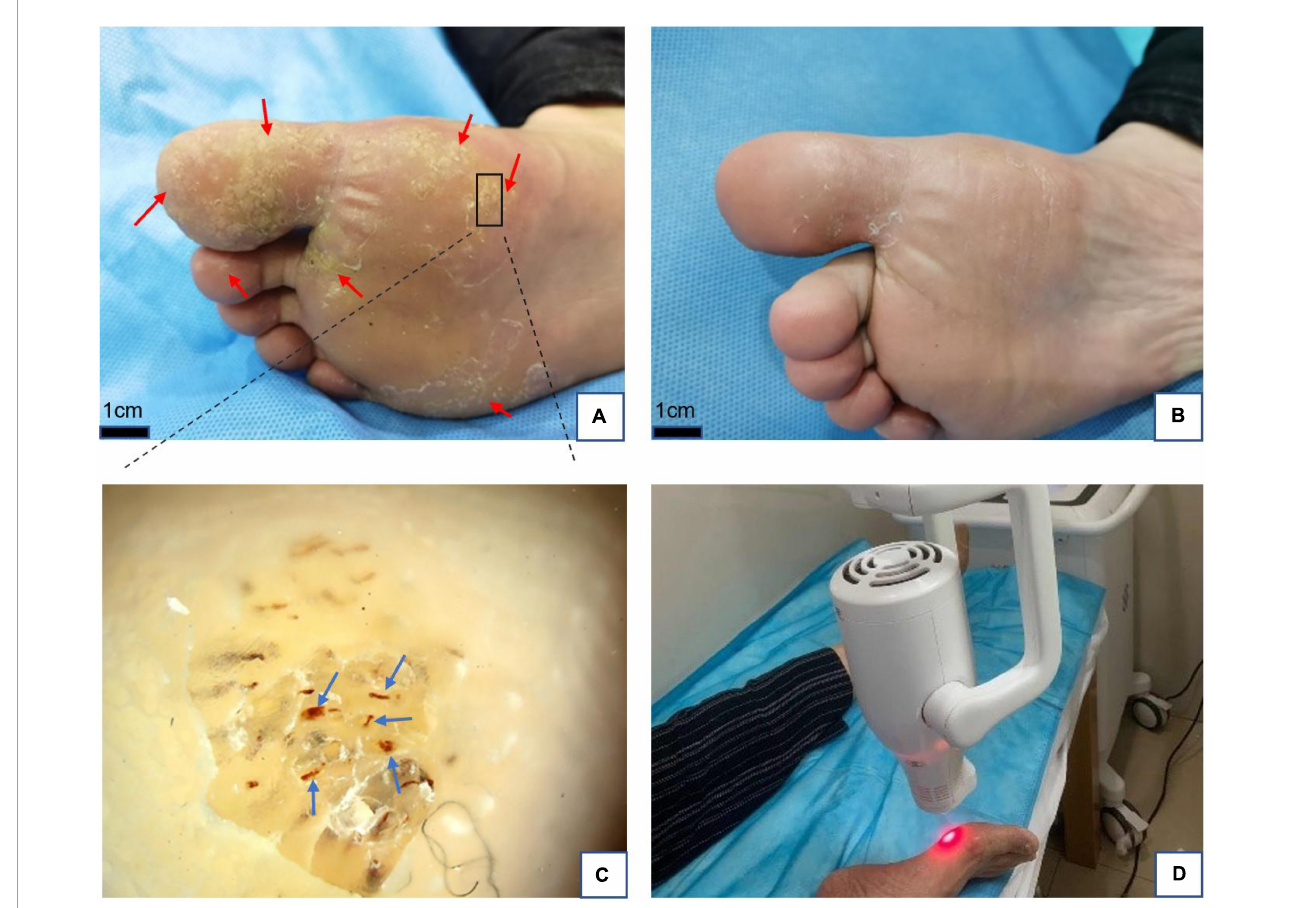
FIGURE1 (A) Plantar warts (red arrows) before treatment. (B) Five weeks after treatment with local hyperthermia (complete resolution). (C) Dermoscopic findings in warts, red dots, and linear vessels (blue arrows) on the papilliform surface. Dermoscope 50 × magnification. (D) Clinical application of local